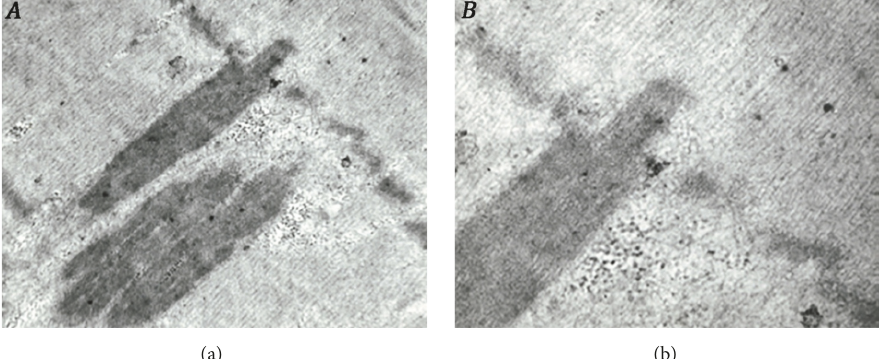
Figure 3: By EM, nemaline bodies are oriented consistently with the longitudinal axis of the fibers and they are composed of myofibrillar material in apparent continuity with Z-bands ((a), x 28.000; (b), x